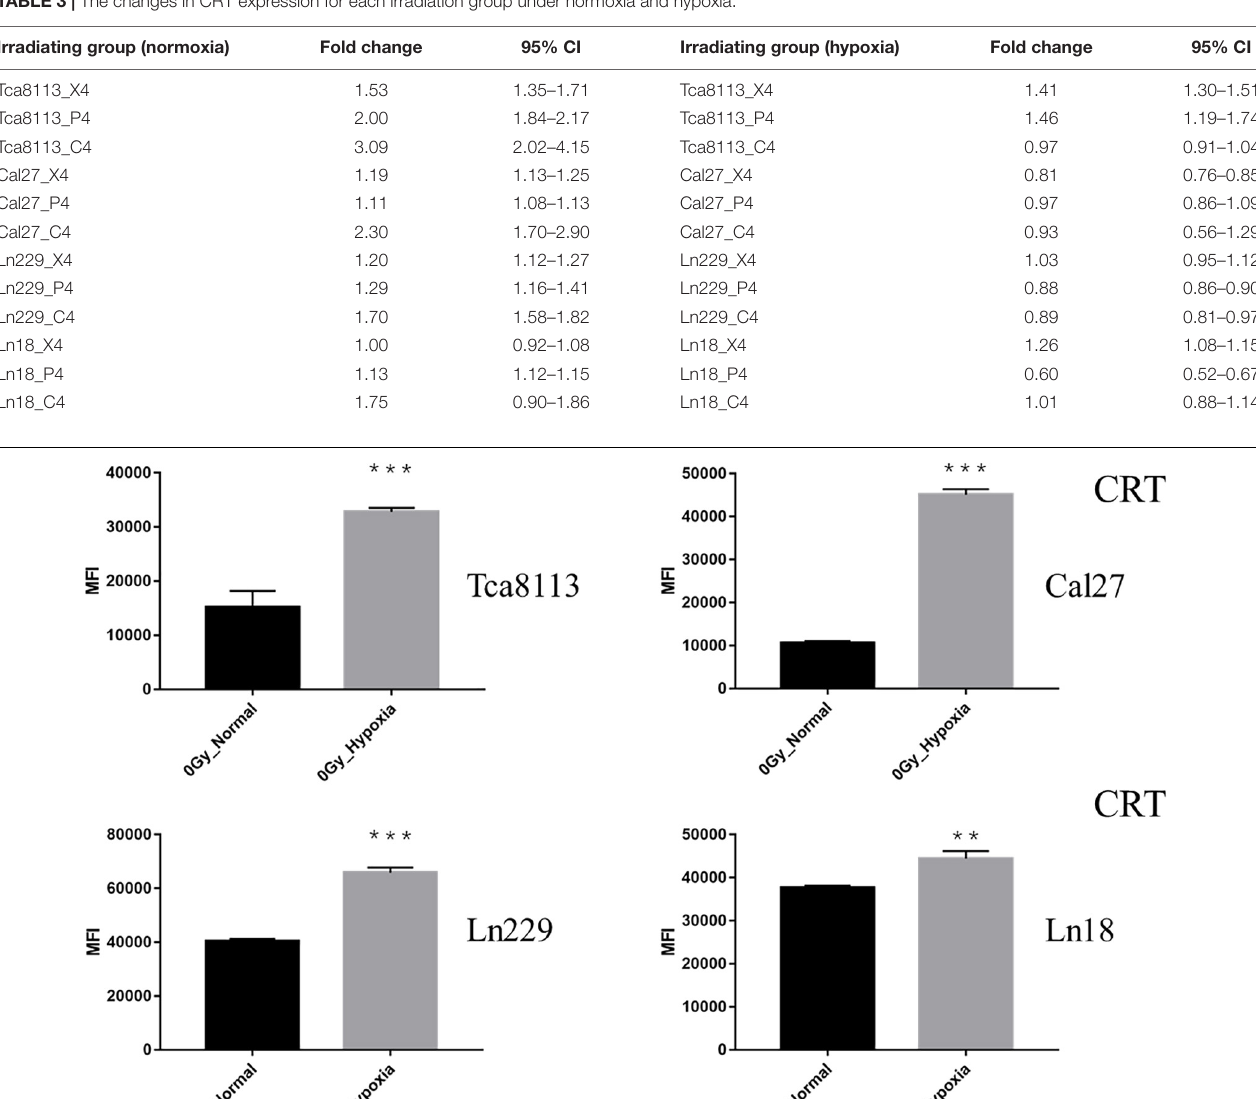
TABLE 3 | The changes in CRT expression for each irradiation group under normoxia and hypoxia. Irradiating group (normoxia) Fold change 95% CI